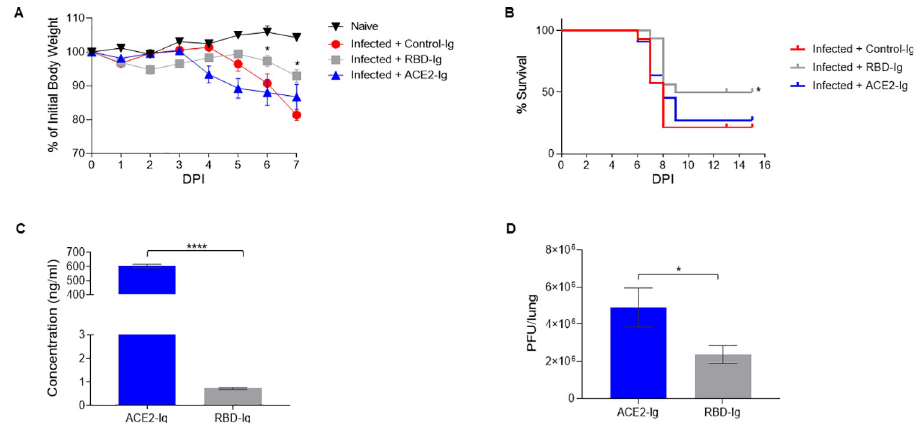
Fig 3. RBD-Ig decreases disease severity of SARS-CoV-2 infected mice . (A) Homozygous female K18-hACE2 transgenic mice were infected with SARS-CoV-2 (day 0) and treated with 75 μ g/mouse of either Control-Ig, RBD-Ig or ACE2-Ig. % of initial body weight was calculated from mice which were weighed daily. � P < 0.05; Student’s t-test as compared to Infected + Control-Ig. (B) Survival percentages of SARS-CoV-2 infected mice treated as described in A. � P < 0.05; Mantel-Cox test as compared to Infected + Control-Ig. (A-B) n = 7–8 , data are mean ± SEM of two independent experiments. (C-D) Homozygous female K18-hACE2 transgenic mice were infected with SARS-CoV-2 (day 0) and treated at 1, 2, 3 DPI with 2nmol/mouse of RBD-Ig ( n = 10 ) or ACE2-Ig ( n = 10 ), at 5 DPI mice were sacrificed, sera was collected and lung harvested. � P < 0.05; ��� P < 0.0005; Student’s t-test. Data are mean ± SEM. (C) ELISA was performed from collected sera to detect fusion protein presence. (D) PFU in the harvested lungs of mice treated with ACE2-Ig or RBD-Ig.